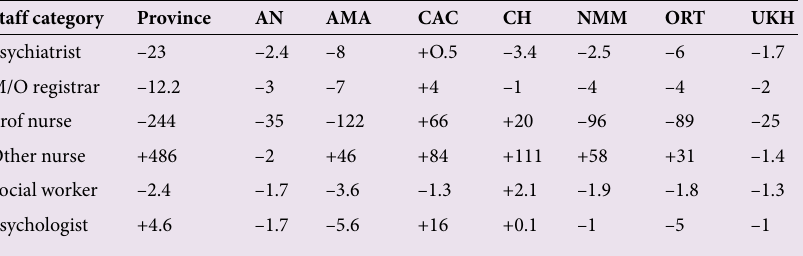
Table 11. Gap analysis for staff deficits (–) or excesses (+) Staff